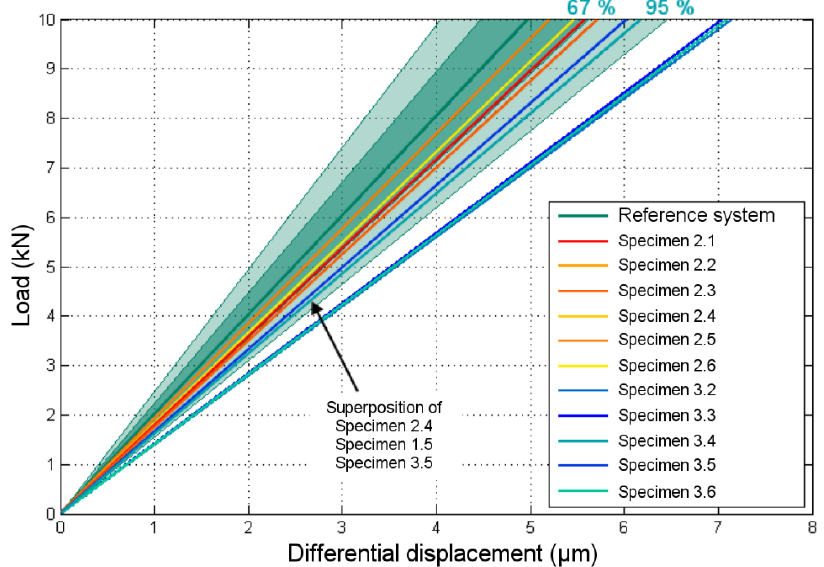
Figure 9. Load vs. displacement curves for specimens with Adhesive 2 and Adhesive 3, and probability distributions for the reference system.